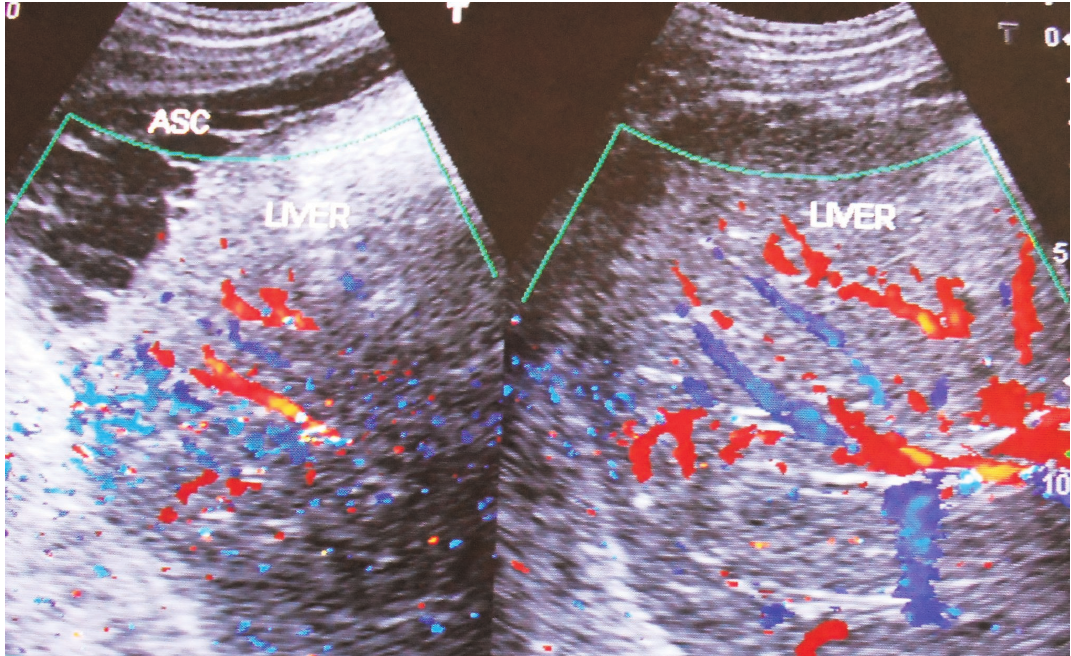
Figure 5. Ultrasonography and color Doppler of a patient with HVCS showing ascites with evidence of chronic peritonitis — Multiple intraperitoneal adhesions. Note the thrombosed, medium-sized branches of portal veins. ASC, ascites. (Copyright: Santosh Man